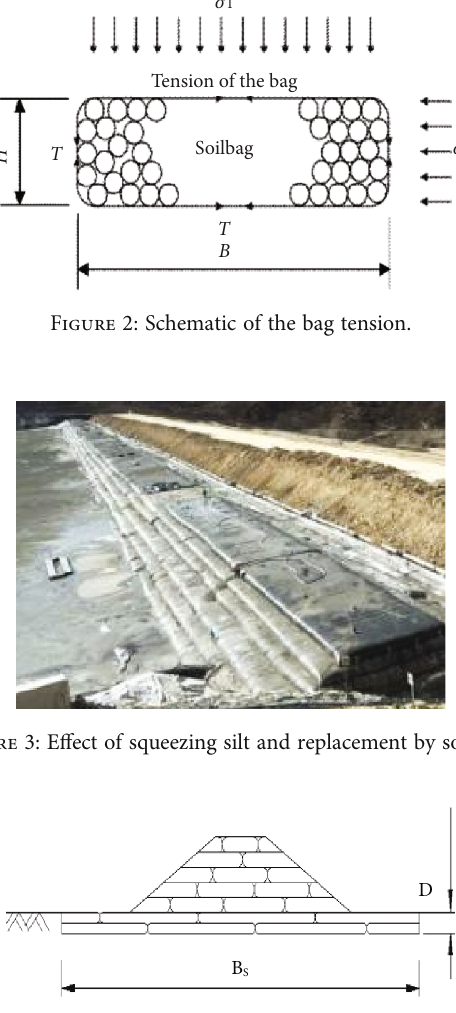
Figure 4: Schematic diagram of the reinforcement of the soft foundation using